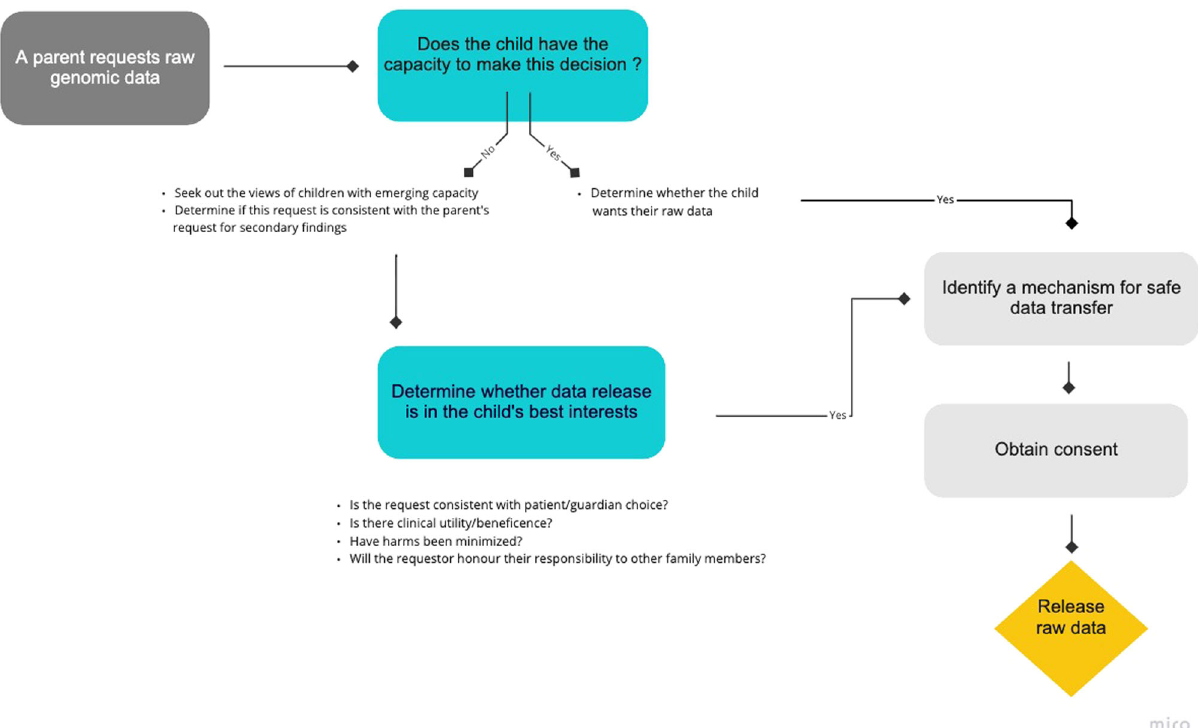
Fig. 1 Framework and approach to raw genomic data requests. This fi gure guides the clinician through the various steps involved in determining whether raw data should be released. It captures important elements such as assessing the child ’ s capacity, considering the best interests of the child, and obtaining informed consent. This process is meant to occur in a setting that involves appropriate genetic